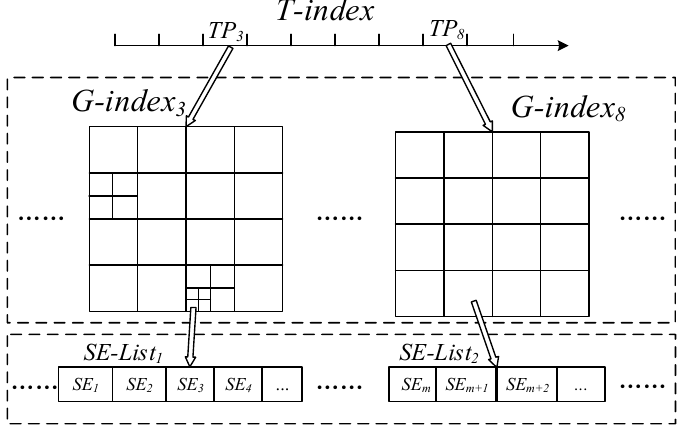
Figure 3. L-index Structure.